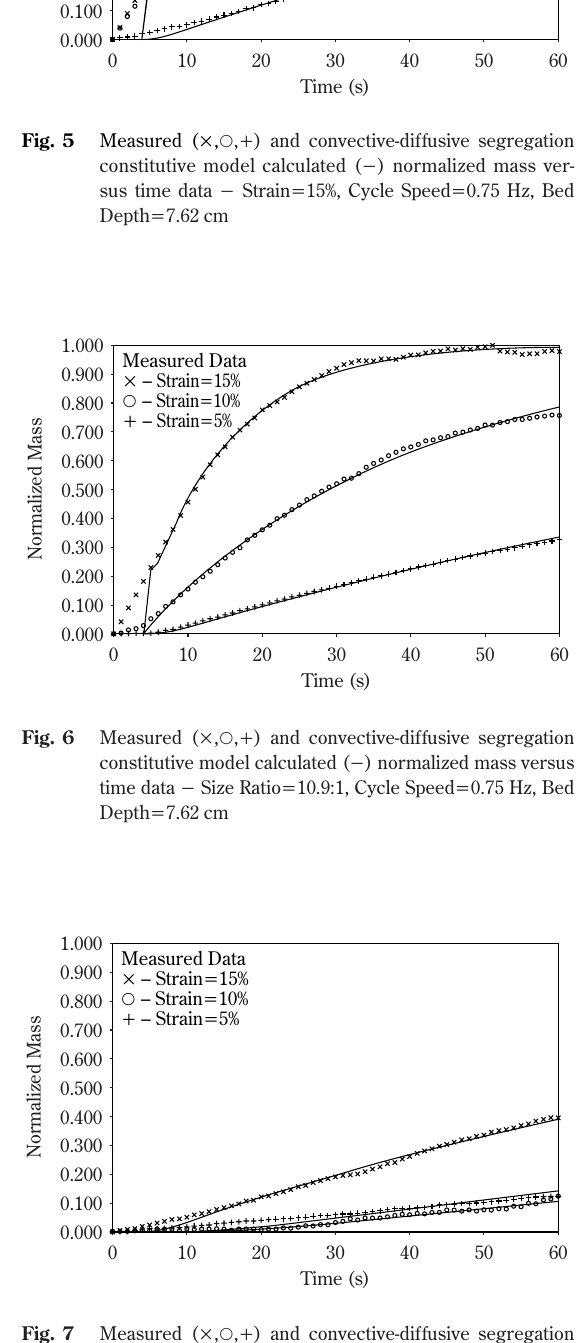
Fig. 7 Measured ( (cid:1) , (cid:1) , (cid:6) ) and convective-diffusive segregation constitutive model calculated ( (cid:4) ) normalized mass versus time data (cid:4) Size Ratio (cid:5) 5.1:1, Cycle Speed (cid:5) 0.75 Hz, Bed Depth (cid:5) 7.62 cm